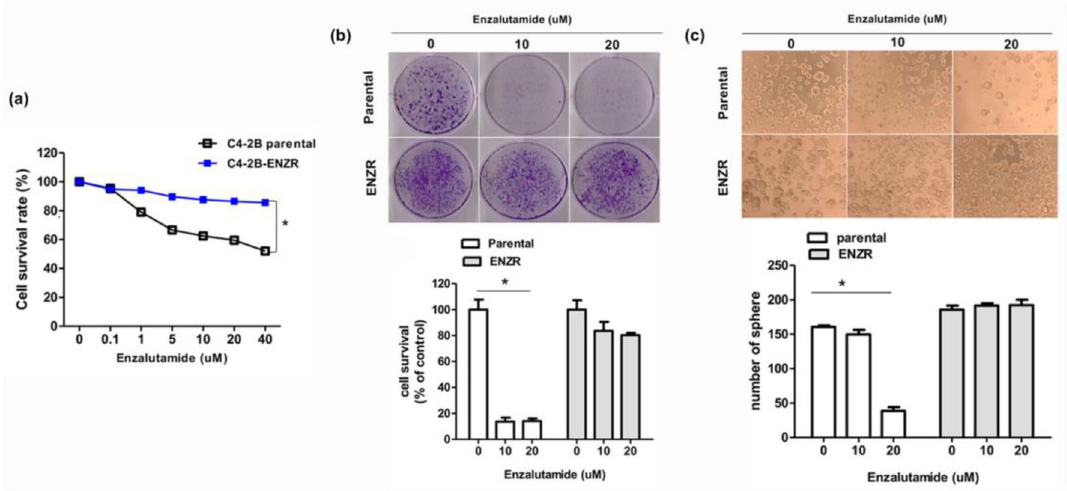
Figure 1. C4-2B MDVR cells are resistant to enzalutamide in vitro. ( a ) C4-2B parental and C4-2B ENZR cells were treated with different concentrations of enzalutamide for 72 h, the cells were measured using the CCK8 solution. * p < 0.005. ( b ) Crystal violet staining for colonies from the same number cells treated with the indicated concentration of enzalutamide. ( c ) C4-2B parental and C4-2B ENZR cells were seeded in an ultra- low attachment 24-well plate. ( d ) The average relative number of crystal violet staining colonies is shown in the lower panel. ( e ) The average relative number of spheroid is shown in the lower panel. Spheroid number was evaluated at 6 days post-seeding. * p <